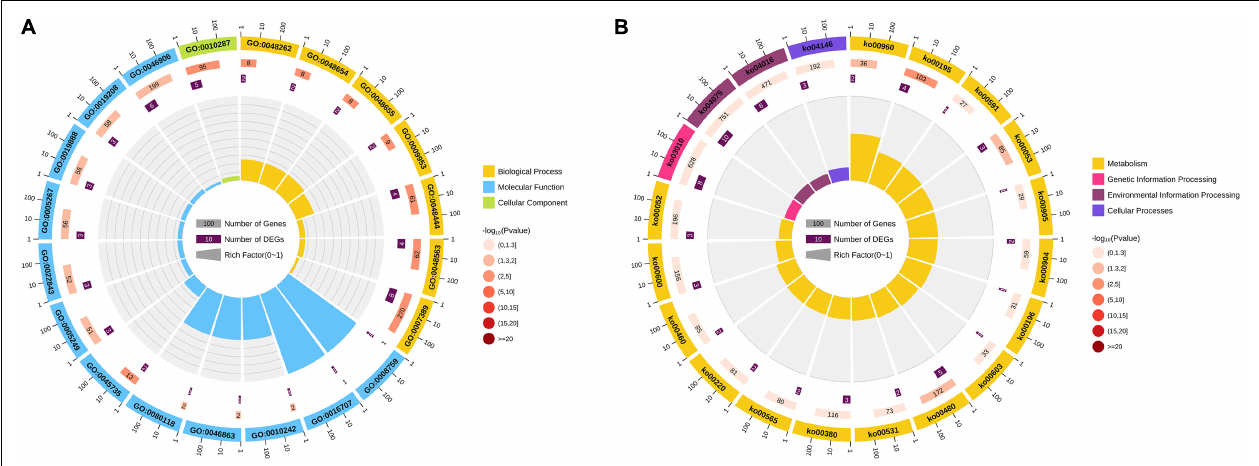
FIGURE 5 | Enrichment circle diagram of Zhengdan958-specific genes. The Top-20 pathway circles of significant enrichment difference were drawn on all the Zhengdan958-specific genes based on GO (A) and KEGG (B) enrichment pathways. Four circles in the circle diagram from outside to inside. The first circle is the enriched classification, and outside the circle is the scale of the number of genes, different colors represent different classifications. The second circle is the number of background genes in this category, the more genes the longer the bar, the smaller the value the redder the color. The third circle shows the total number of target genes. Rich factor value of each classification in the fourth